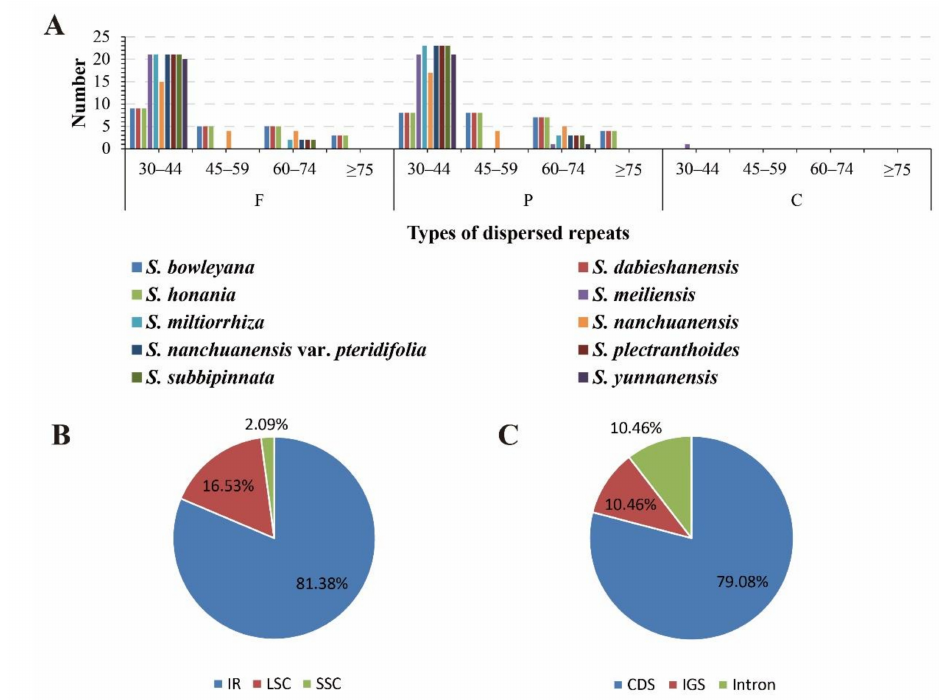
Figure 5. Analysis of repetitive sequences in the plastomes of 10 taxa of Salvia sect. Drymosphace . ( A ). Number of different types of longer repeats; ( B ). frequencies of longer repeats in the LSC, SSC, and IR regions; ( C ). frequencies of longer repeats in protein coding regions, intergenic spacers, and intron regions.